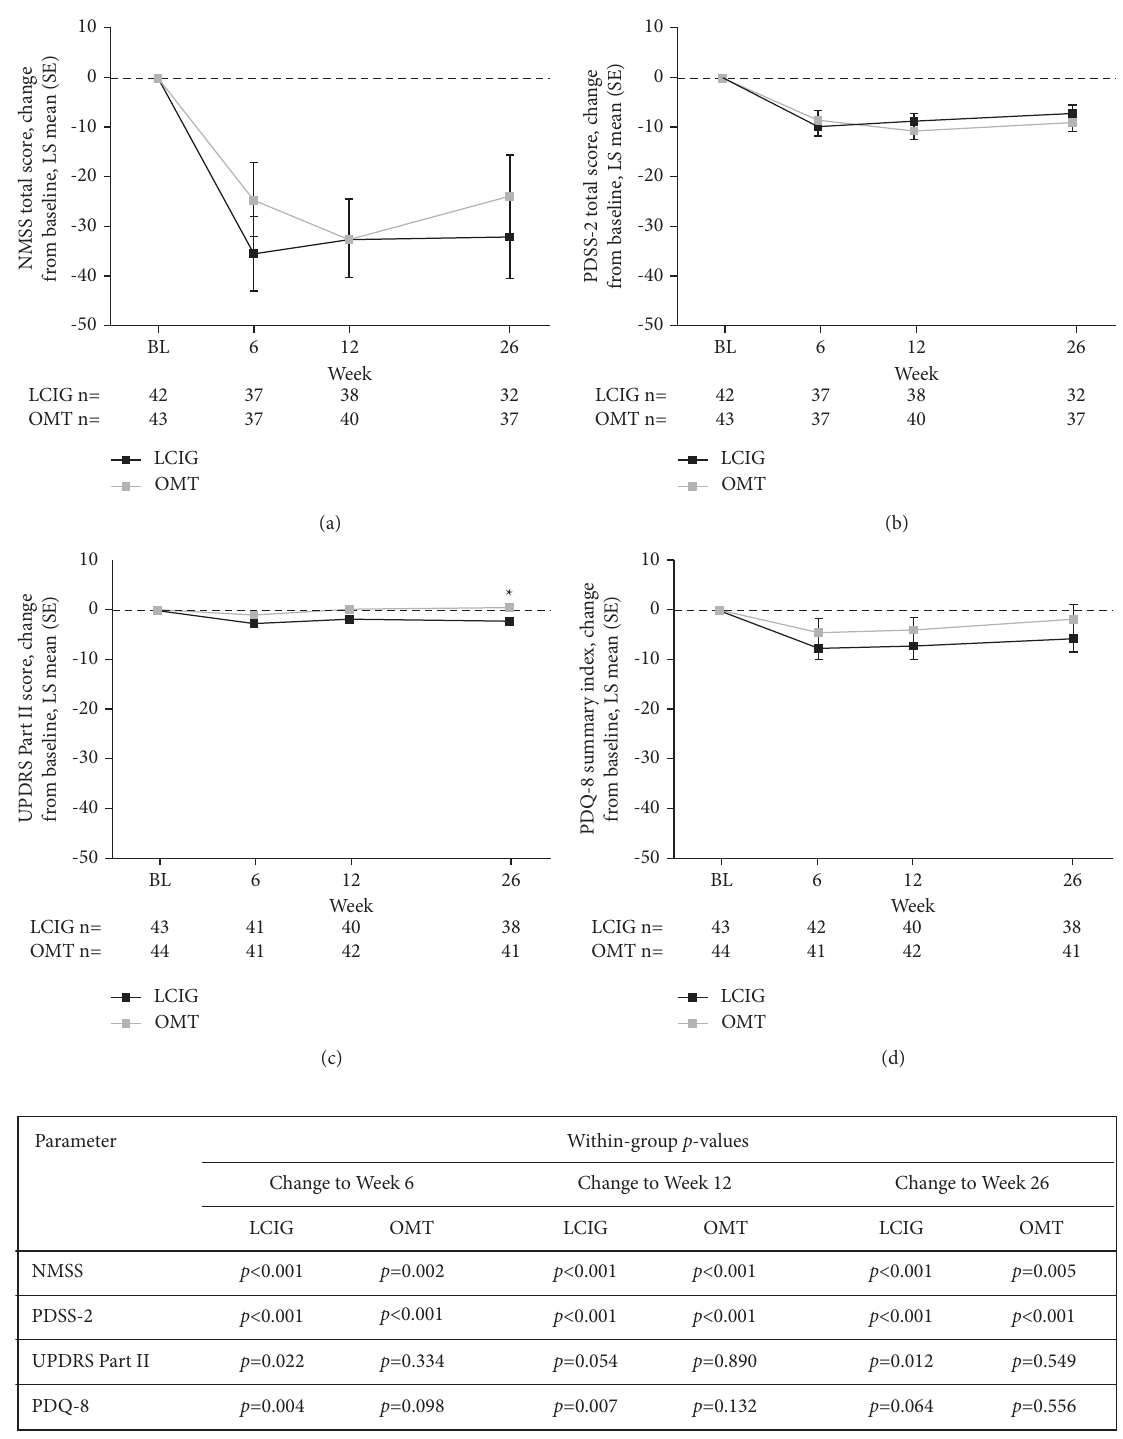
Figure 2: Change from baseline to Week 26 in NMSS (a), PDSS-2 (b), UPDRS Part II (c), and PDQ-8 (d) in the intent-to-treat population. ∗ Nominal between-group diference, p < 0 . 01. Within-group diferences versus baseline are noted in table, with signifcant p -values at p < 0 . 05 in bold. LCIG: levodopa-carbidopa intestinal gel, LS: least squares, NMSS: Non-Motor Symptom Scale, OMT: optimized medical treatment, PDSS-2: Parkinson’s Disease Sleep Scale, PDQ-8: Parkinson’s Disease Questionnaire-8 item summary index, SE: standard error, and UPDRS: Unifed Parkinson’s Disease Rating nominally signifcant reduction from baseline to Week 26 in UPDRS Part IV was larger for LCIG versus OMT (LS mean (SE) = − 2.3 (0.5) vs. − 0.6 (0.5), p � 0 . 007. PGIC score was